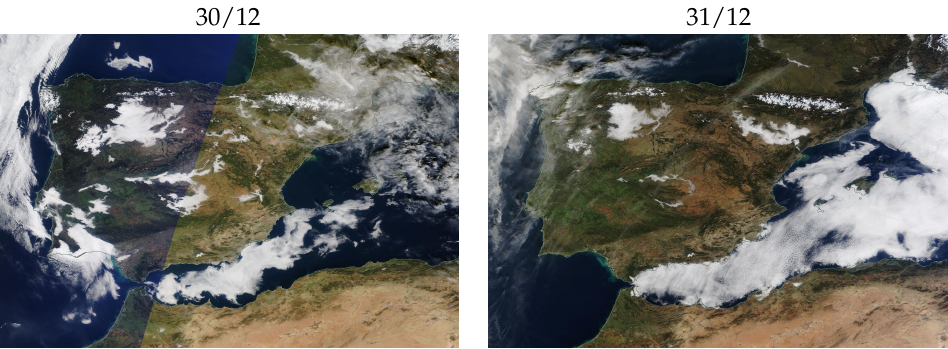
Figure 5. Iberian Peninsula. Terra satellite MODIS images on 30 and 31 December 2021 at approxi- mately 11 UTC (NASA